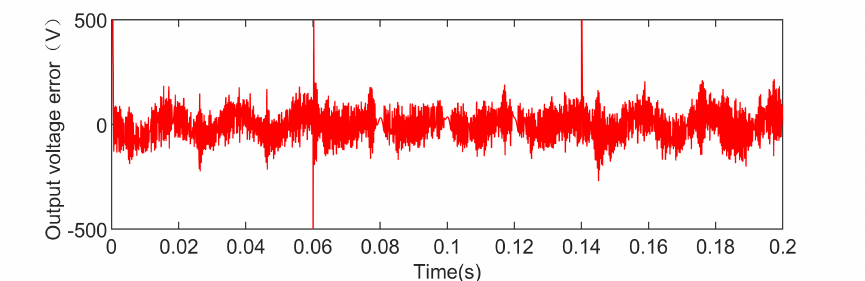
Figure 4. Dynamic performance of output voltage ( u oa ) tracking its desired value ( u ∗ oa ) .